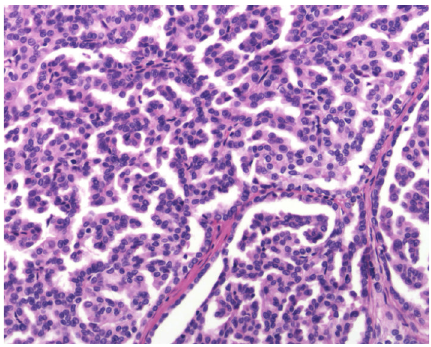
Figure 5: High power view of the papillary renal cell carcinoma seeding along the previous percutaneous biopsy